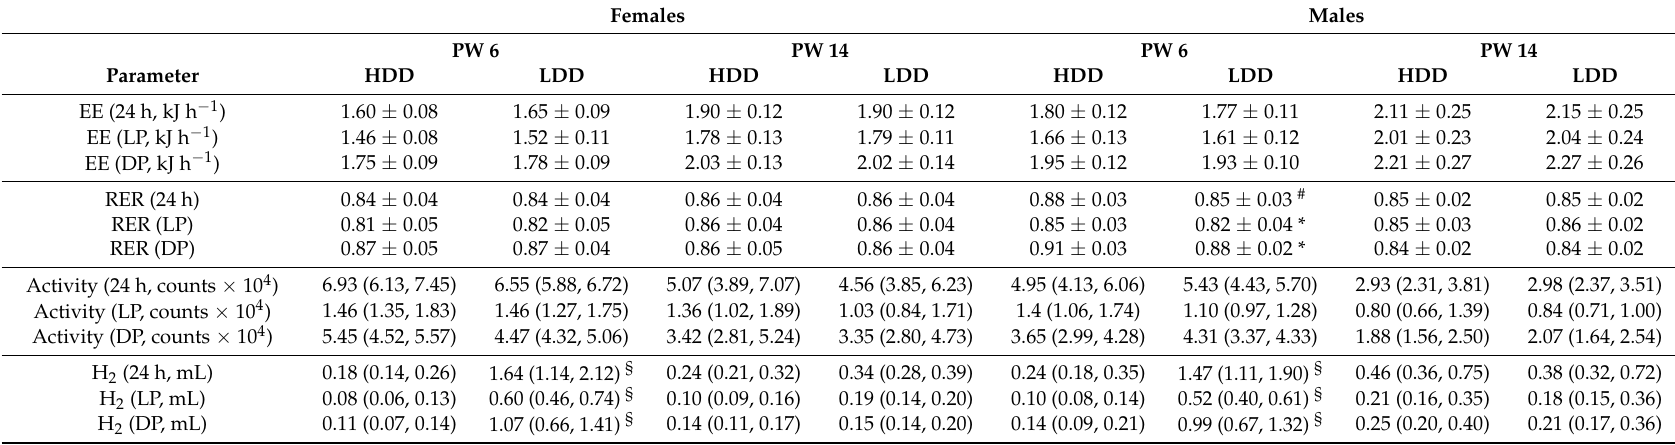
For EE and RER, data is presented as mean ± s.d. For activity and H 2 , data is shown as median (95% CI of mean), since these values often did not follow a normal distribution. Statistically significant differences compared to the HDD for mice of the same age and sex denoted as * p ≤ 0.05, # p ≤ 0.01, and § p < 0.0001. DP: dark phase; EE: energy expenditure (averaged